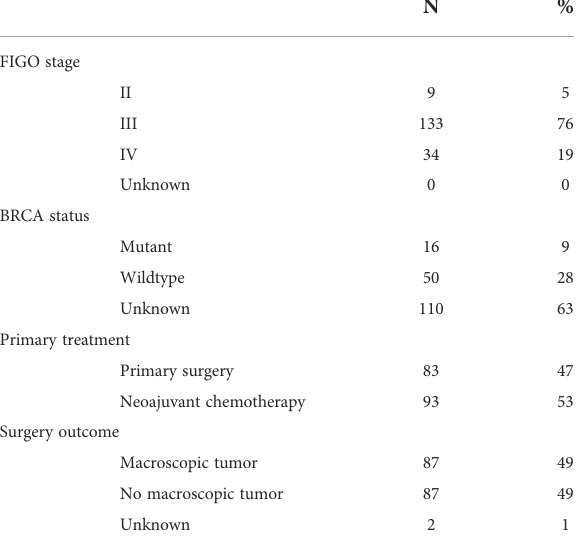
FIGO, Fe ́ de ́ ration Internationale de Gyne ́ cologie et d ’ obste ́